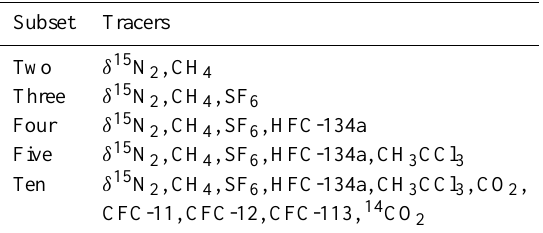
Table 2. Subsets of tracers used for calibration of diffusivity at NEEM (pseudo and real observations), where the name reflects the number of tracers